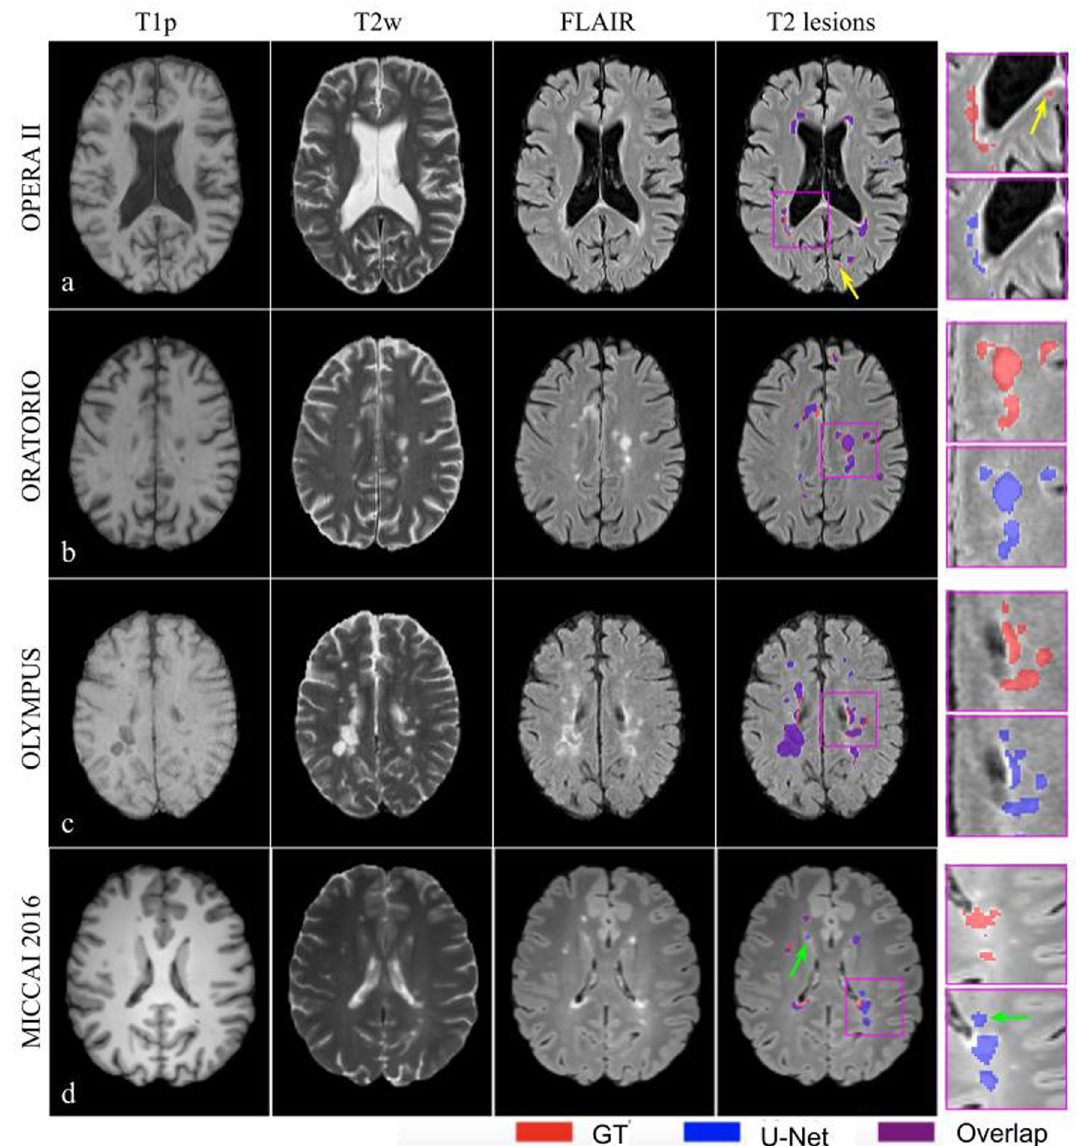
Figure 2. Illustrative examples of T2 lesion segmentations from GT and multi-arm U-Net predicted masks. The inputs to the model: T1p, T2w, and FLAIR MRI, are shown in columns 1–3. Column 4 shows the overlay of T2 lesions on FLAIR MRI, with GT shown in red, model predictions in blue, and their overlap shown in purple. Magnified insets are shown in column 5 for a better visualization of the segmentation agreement between model predictions and GT annotations. Yellow arrows point to false negative lesions and green arrows point to false positive lesions. Rows ( a – c ) are examples of T2 lesion segmentations from internal test sets of a patient with relapsing MS in the OPERA II trial ( a ) and patients with PPMS in the ORATORIO ( b ) and OLYMPUS ( c ) trials. Row d corresponds to an illustrative patient with MS in the MICCAI 2016 dataset used as the external test set here. The examples highlight the good agreement of model predictions with GT masks and have high sensitivity to detect a majority of small lesions across various test sets. GT ground Association of T2 lesion metrics with clinical outcome scores. In the OPERA II dataset, log-trans- formed baseline T2 TLV showed a trend ( p = 0.06) towards association with CDP24 when using the GT or model-predicted masks (Table 4) in the univariable CPH analysis. The KM curves stratified by median baseline T2 TLV showed a separation in the control arm but not in the treatment arm (Fig. 4a). The separation of KM curves in the control arm was statistically significant in a log-rank test when using model-predicted masks (Fig. 4b). In the multivariable CPH model, after accounting for covariates, the log-transformed baseline T2 TLV had a statistically signification association with CDP24 (Table 4). Baseline T2 TLC was not associated with the four outcome measures. In the univariable CPH analysis of the ORATORIO dataset, log-transformed baseline T2 TLV was associated with 9HPT24 but was not significant in a multivariable CPH model (Table 4). KM curves from GT and model-predicted masks revealed a clear separation in the placebo arm and no separation in the